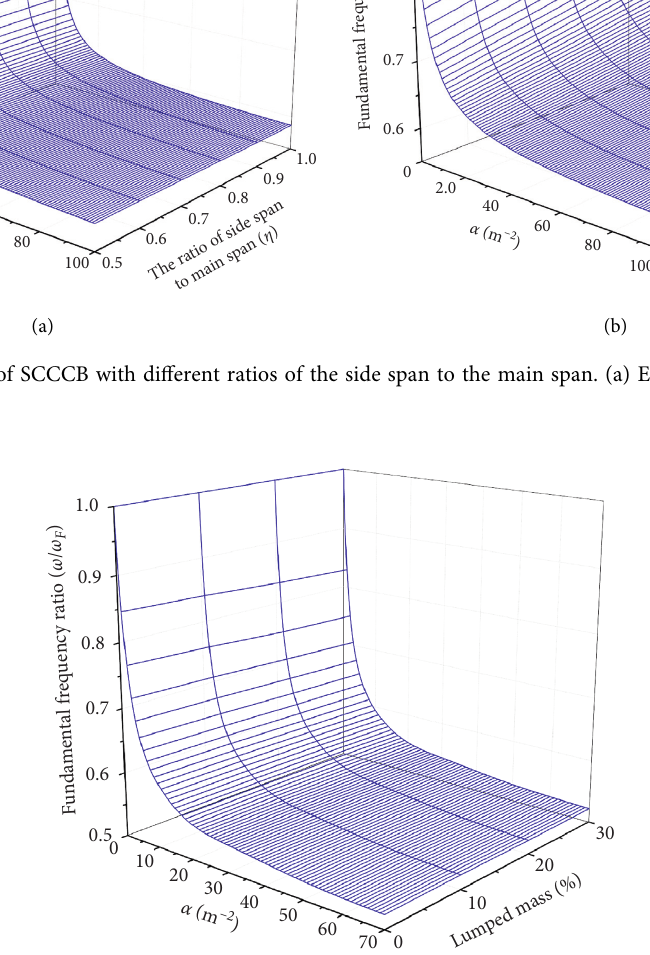
Figure 12: The values of ω / ω F of SCCCB with different lumped masses.